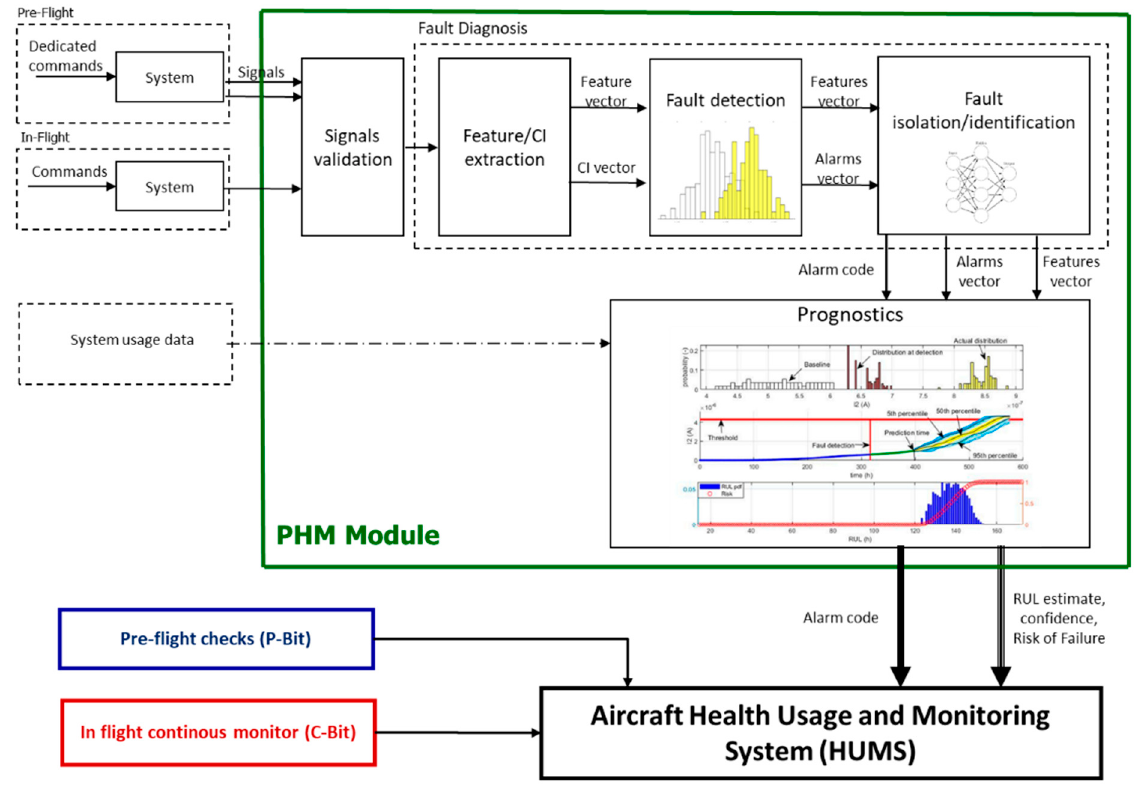
Figure 8. The PHM framework.